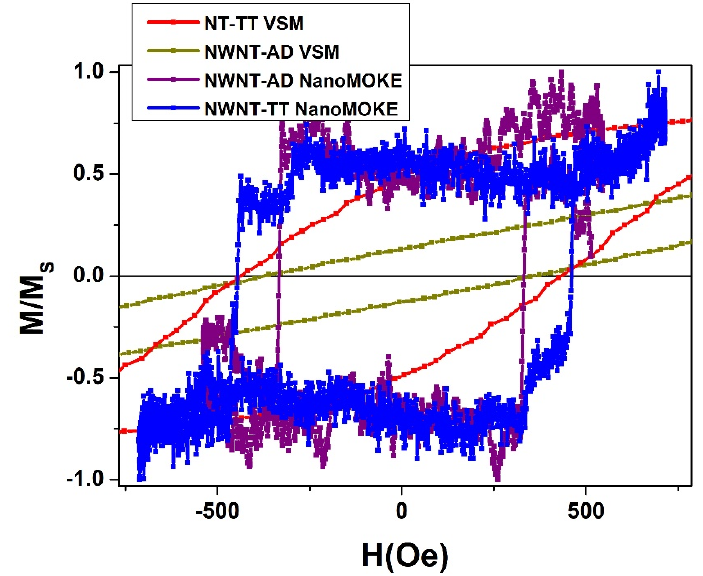
Figure 6. VSM hysteresis loops of the NT-TT (red) and NWNT-AD (dark yellow) arrays. MOKE hysteresis loops of individual Fe 56 Co 44 nanowires (purple) and core/shell bimagnetic nanowire (blue). All hysteresis loops are measured by applying the external field along the parallel direction with respect to the nanowires/nanotubes longitudinal axis.